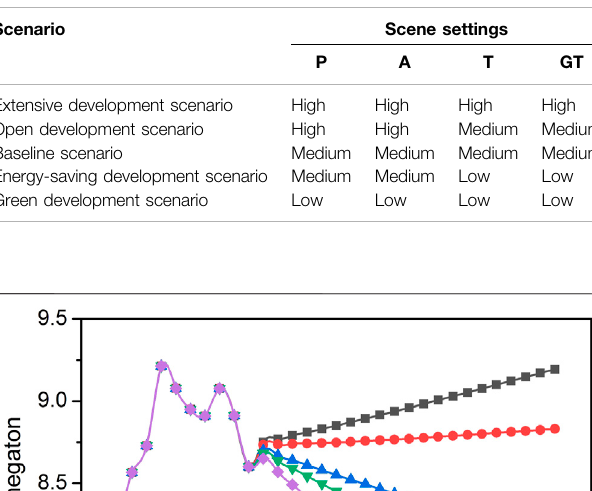
TABLE 4 | Change rate of in fl uencing factors of national port carbon emission. TABLE 5 | Carbon emission scene setting of ports.